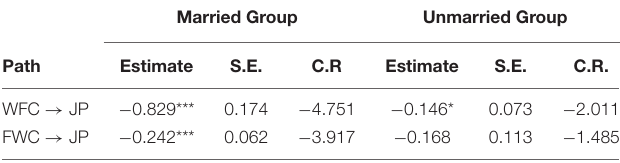
TABLE 7 | Results of the multi-group comparison